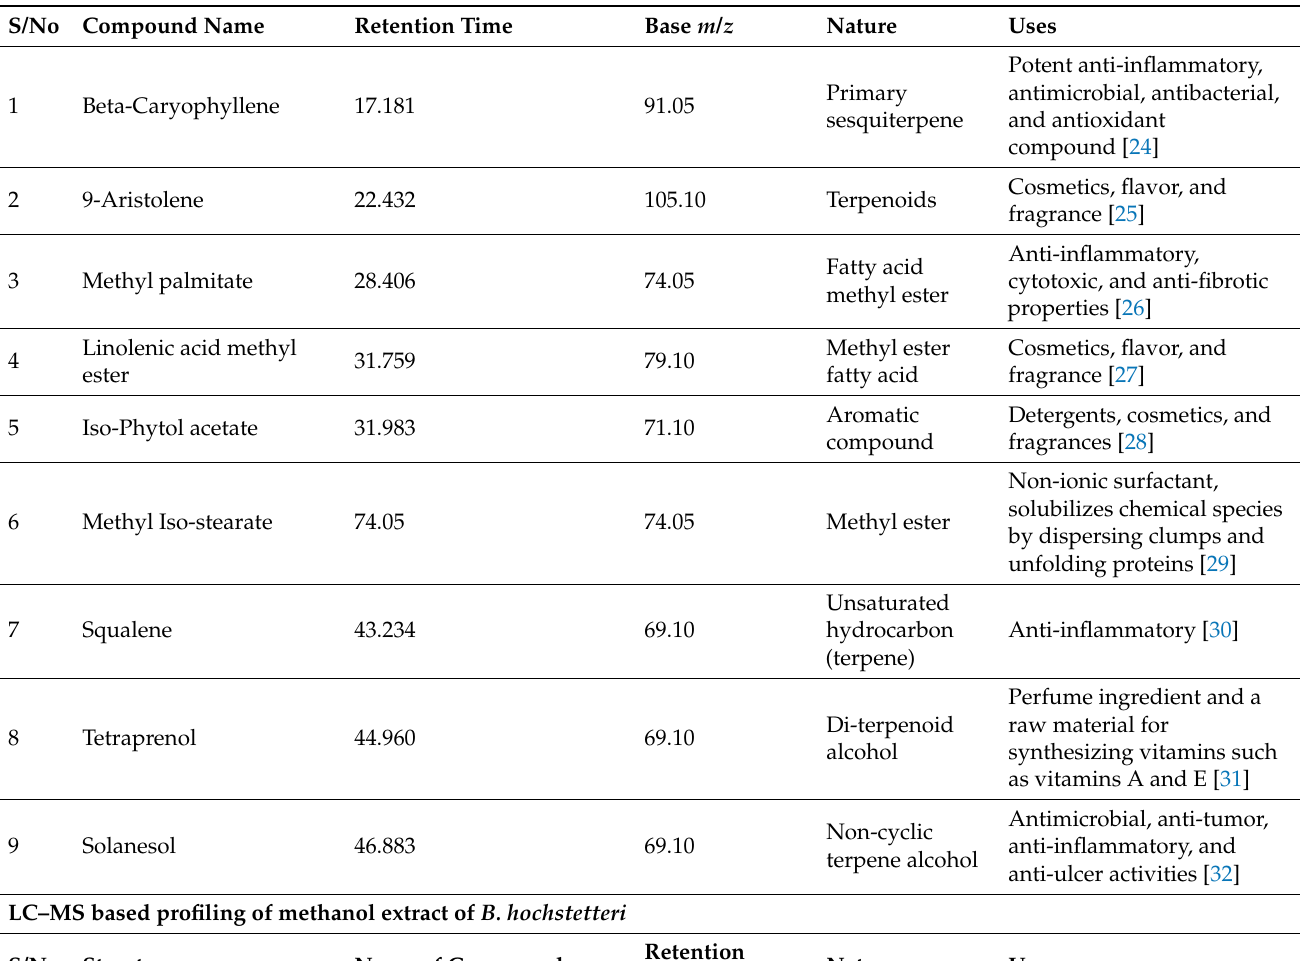
Table 3. GC–MS and LC–MS profiling of methanol extract of B. hochstetteri